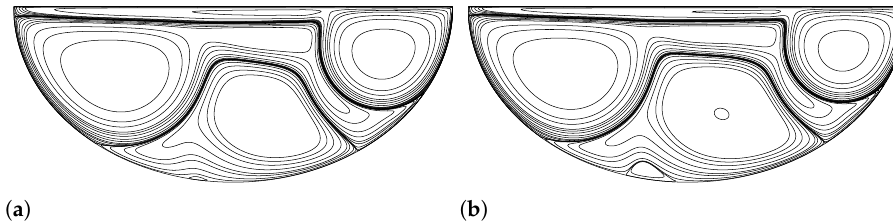
Figure 16. The evolution of the 1st solution of driven semi-elliptical cavity flow above Re = 19,000 for D = 0.80 aspect ratio. ( a ) Re = 20,000 (1st solution). ( b ) Re = 25,000 (1st